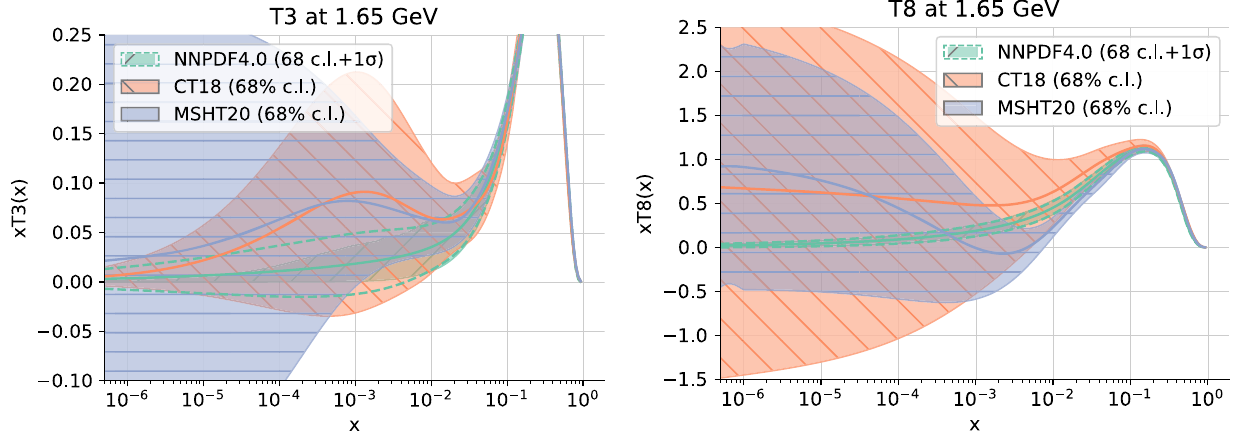
Fig. 49 Same as Fig. 48 now comparing the NNPDF4.0 baseline to CT18 and